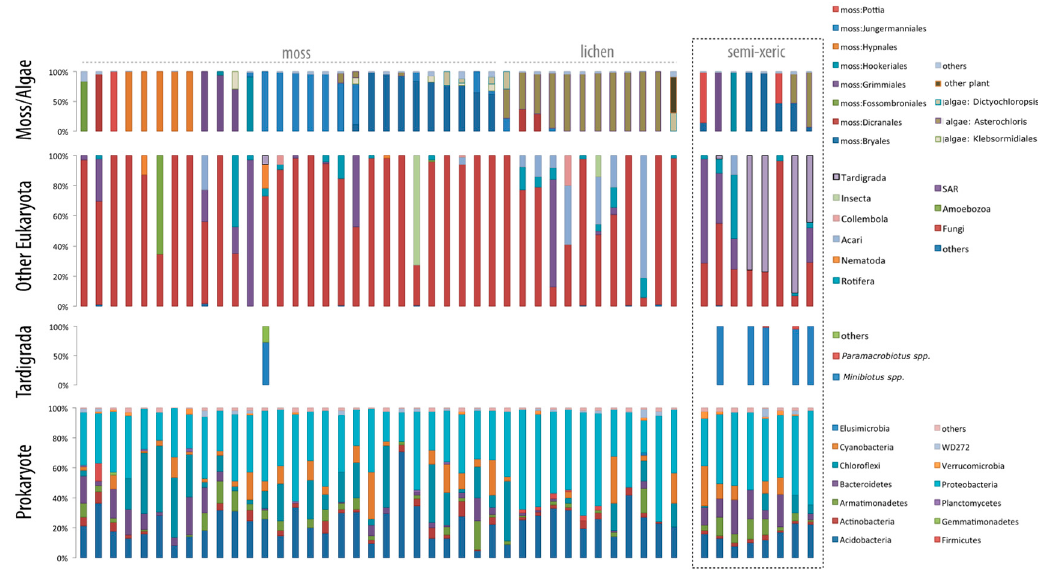
Figure 3. Amplicon abundance ratios in mesic mosses. Relative abundances of amplicon reads within OTUs assigned to moss / lichen, other Eukaryota, tardigrades, and bacteria are shown separately. Forty samples were collected from mosses or lichens on rocks or tree surfaces within a cedar forest, and eight samples were collected from semi-xeric mosses near the road just outside of the forest. Moss species varied among samples, but lichen samples were dominated by the green algal genus Asterochloris . Fungi was dominant in almost all of the samples among eukaryotes, and almost no tardigrades were detected in the mesic samples. The largest bacterial clades were Proteobacteria and Acidobacteria. The full list of OTUs is available in the Supplemental